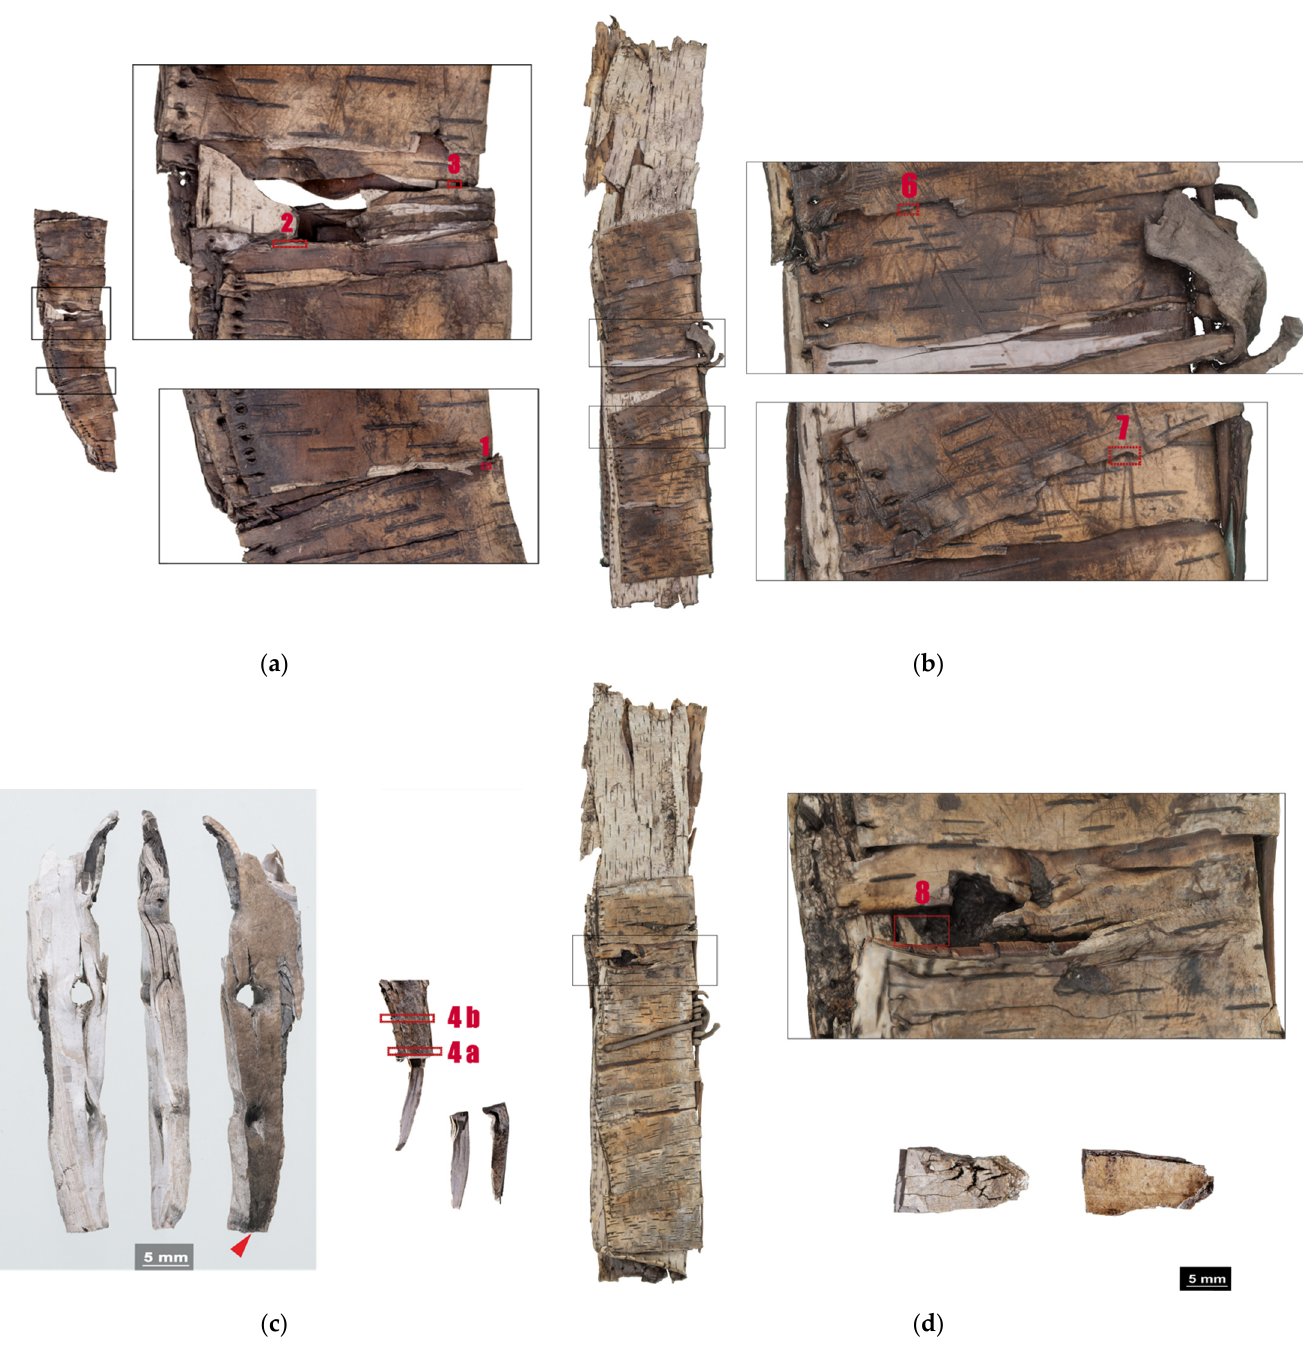
Figure 4. ( a ) Lower and ( b ) upper part of Schnidejoch bow case body, ground-facing side; ( d ) upper part, upward facing. Samples were taken from outer bark strips (1, 6, 7), middle bark strips (2) and inner lining (3, 4, 8). Outer and middle bark strips of bow case body have outer bark surface oriented towards inside, and inner lining has outer bark surface oriented towards outside. Sample 4 was extracted from a fragment probably from ( c ) lid inner lining. Sample 5 was a loose fragment found close to the lower part (not shown).